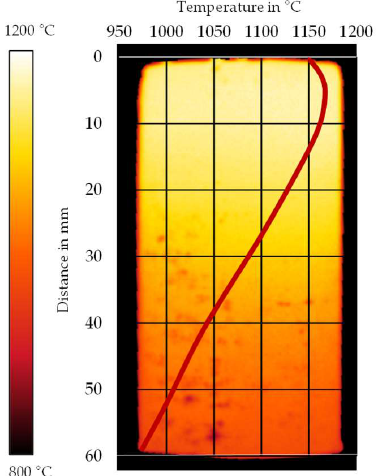
Figure 4. Thermographic image and axial temperature profile measured at the workpiece surface before forming.